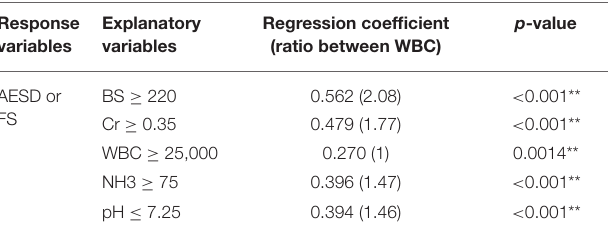
TABLE 5 | Cutoff points and univariate analyses for each laboratory datum which was significantly different between AESD and FS patients at the period of < 3 h. Response